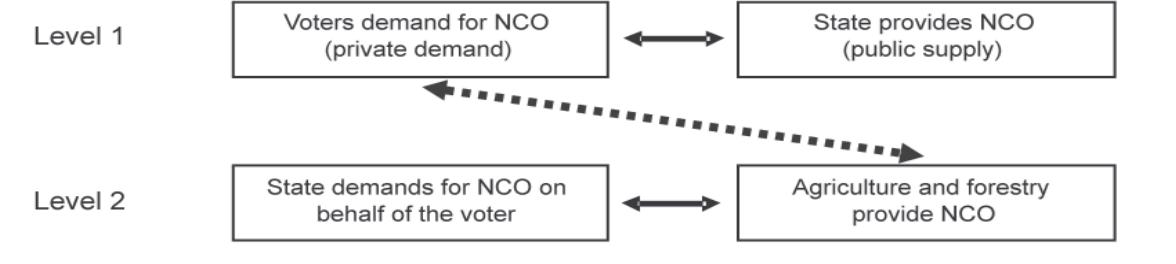
Figure 3. The two-stage process of public provision of NCO from agriculture and forestry, with public goods